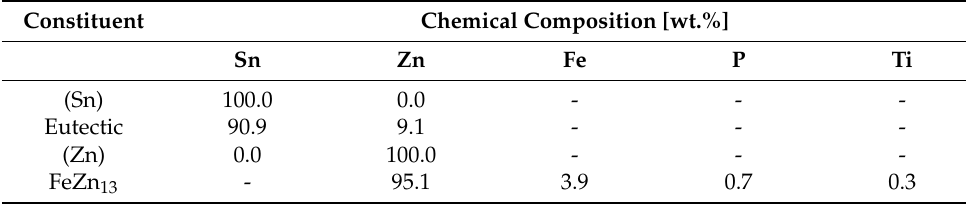
Figure 2. Microstructure of as-cast Sn – Zn alloys: Sn ( a ), Sn – 5Zn ( b ), Sn – 9Zn ( c ), Sn – 15 Zn ( d ), and Zn ( e , f ). Table 1. The chemical composition of the microstructure constituents (EDS point